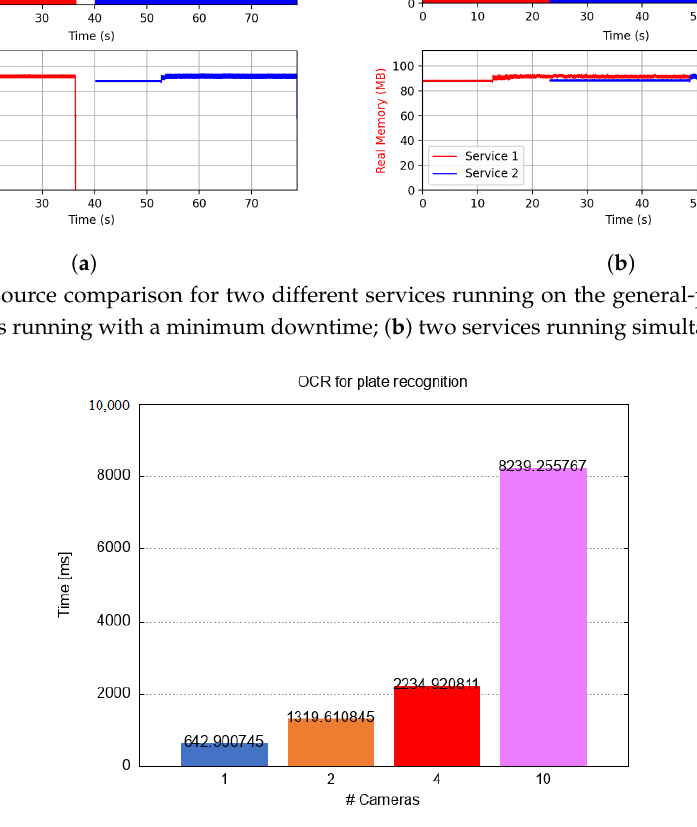
Figure 13. Execution time for performing the OCR (Optical Character Recognition) for number plate recognition on Raspberry considering 1, 2, 4 and 10 cameras connected to the same